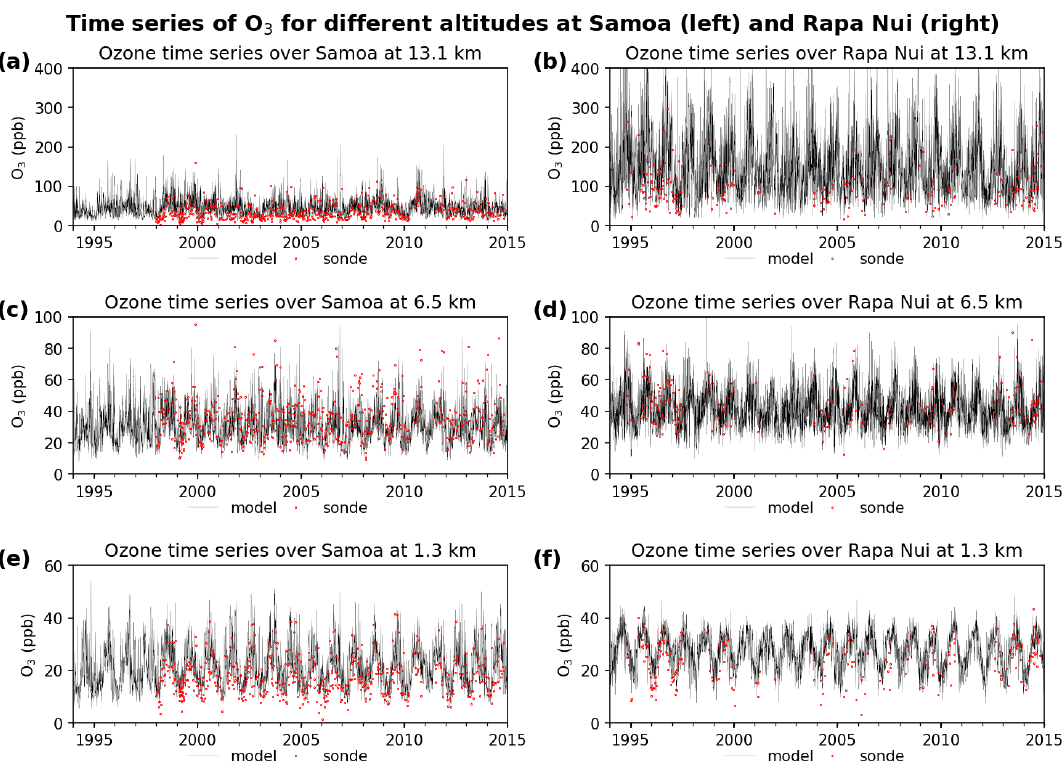
Figure 6. Time series of ozone in the boundary layer (1.3km, e and f ), mid troposphere (6.5km, c and d ), and upper troposphere and lower stratosphere (13.1km, a and b ) as derived from the model (black lines) and ozonesonde measurements (red dots). Data correspond to the period between 1994 and 2014 at Samoa (a, c, e) and Rapa Nui (b, d, f) .